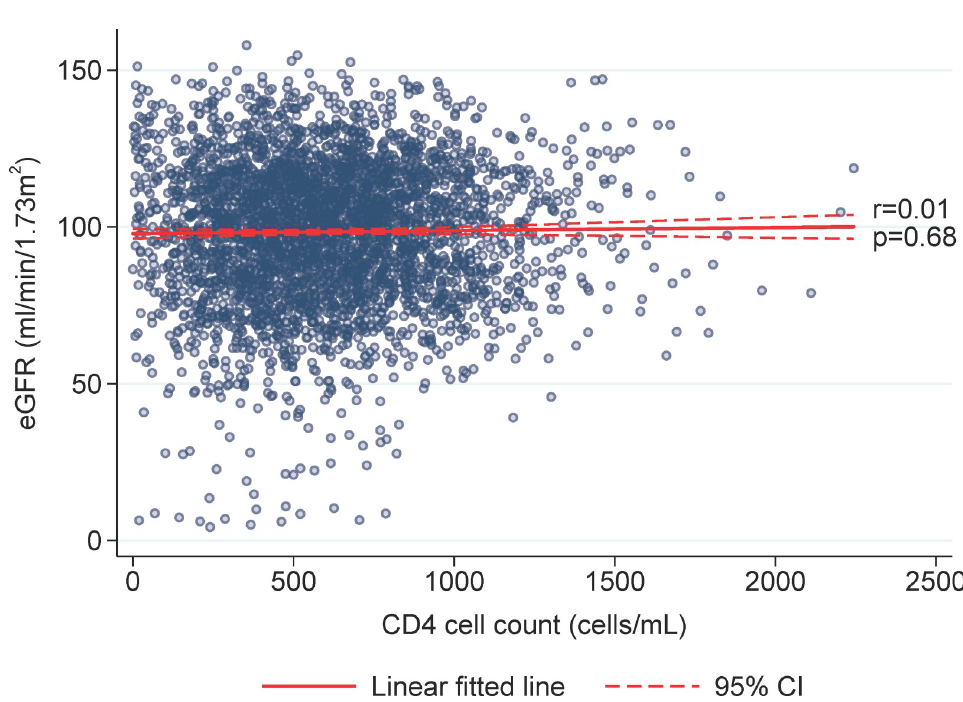
Fig 3. Correlation, eGFR and CD4 count. Spearman’s correlation test with Bonferroni adjustment for multiple measurements.